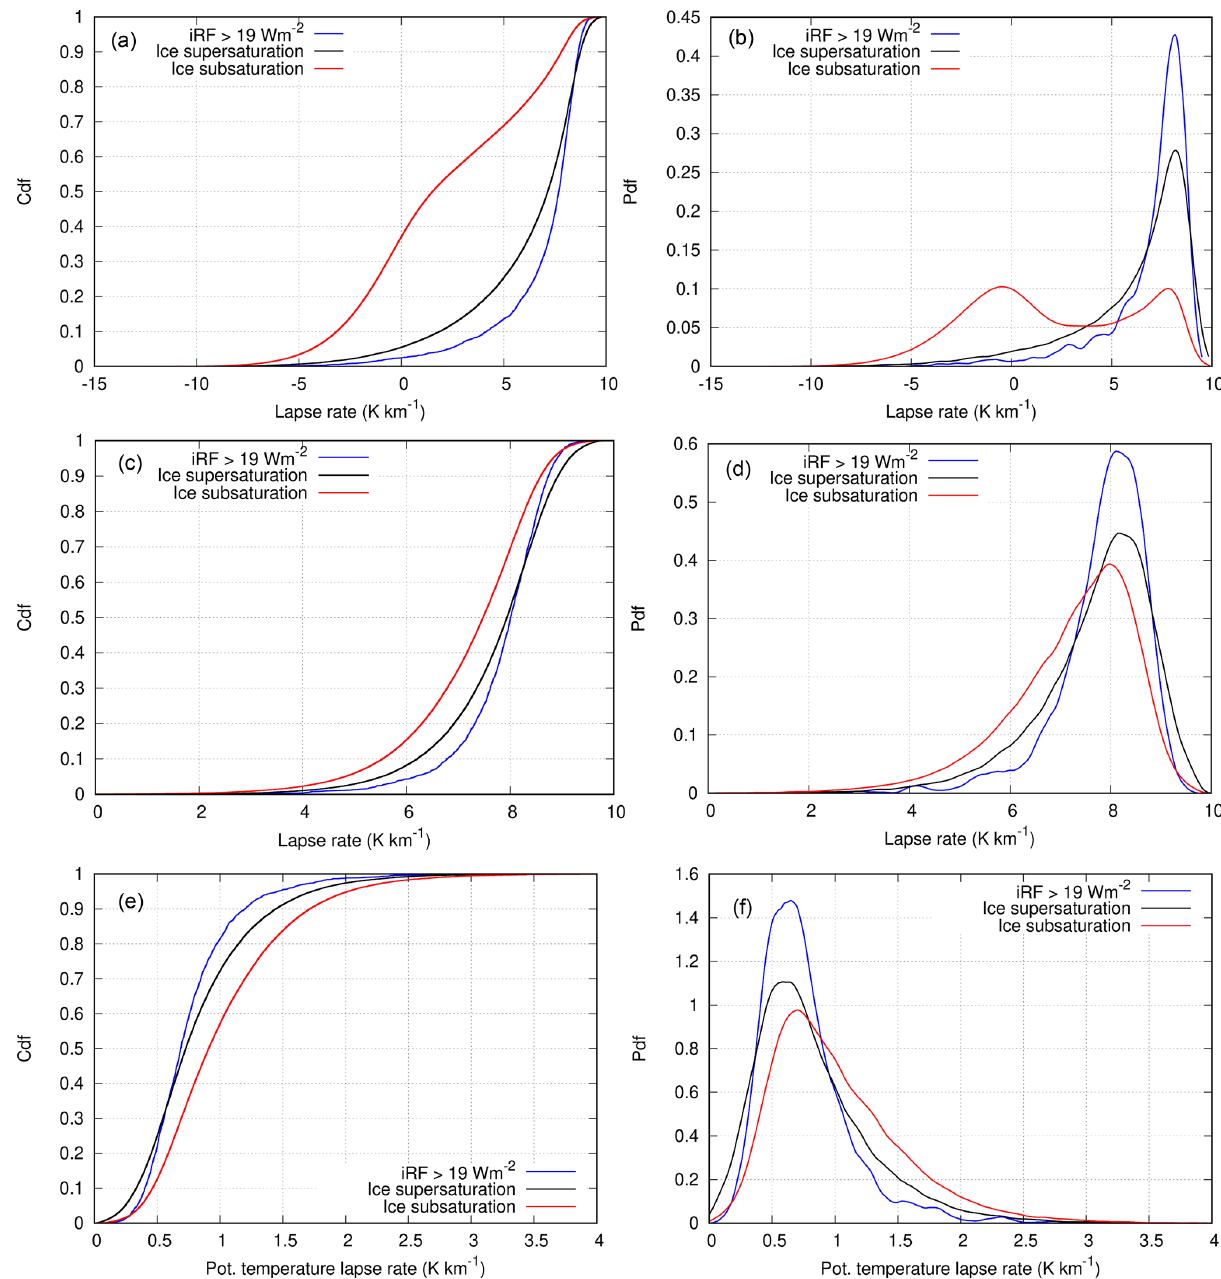
Figure 1. (a) Cumulative distribution function of lapse rates, − d T/ d h , for ice-subsaturated (red) and ice-supersaturated air masses. (b) Probability densities for the same lapse rate distributions. The middle panels show the lapse rate distributions (c) and probability densities (d) excluding stratospheric cases; that is, the upper pressure level of each event has PV ≤ 2 PVU. Please note the different γ ranges plotted in the upper and middle panels. Panels (e) and (f) show the corresponding troposphere-only distributions (e) and probability densities (f) for potential temperature